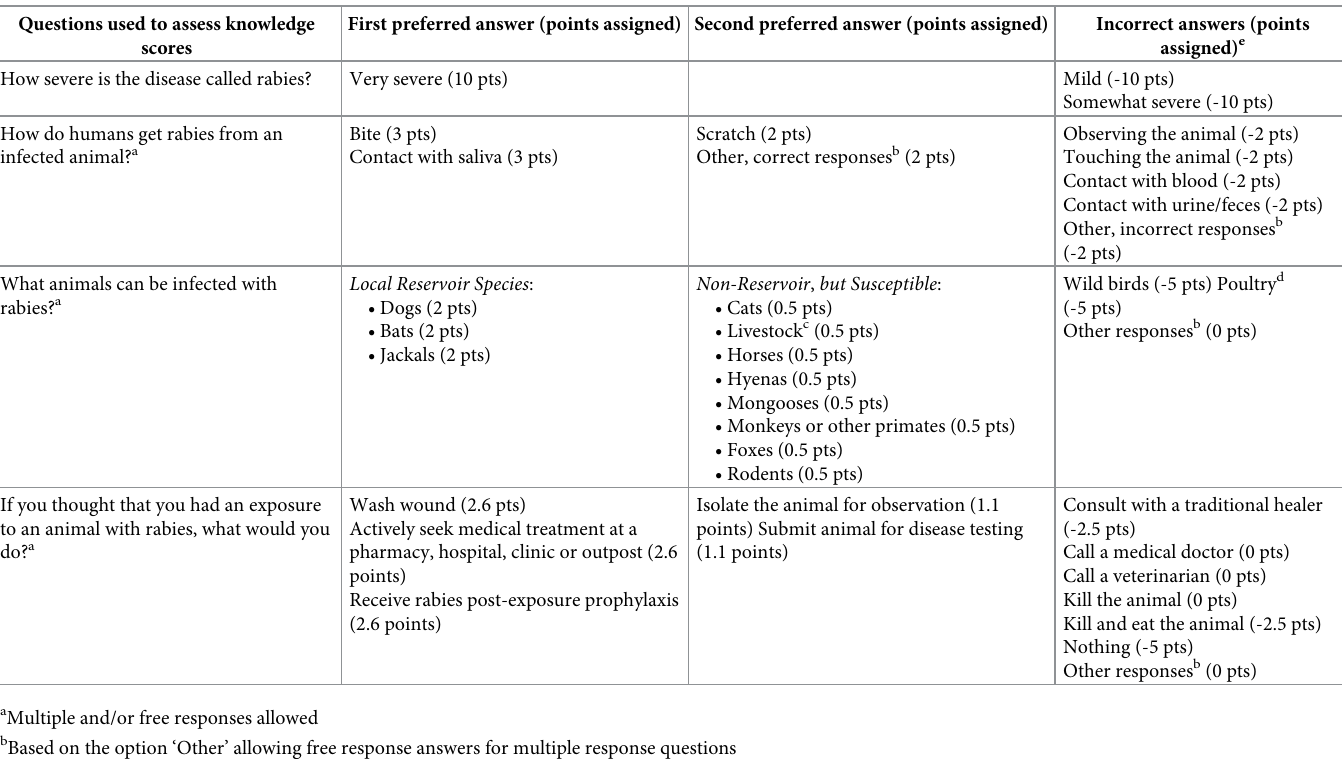
Table 2. Construction of knowledge scores. Questions used to assess knowledge scores